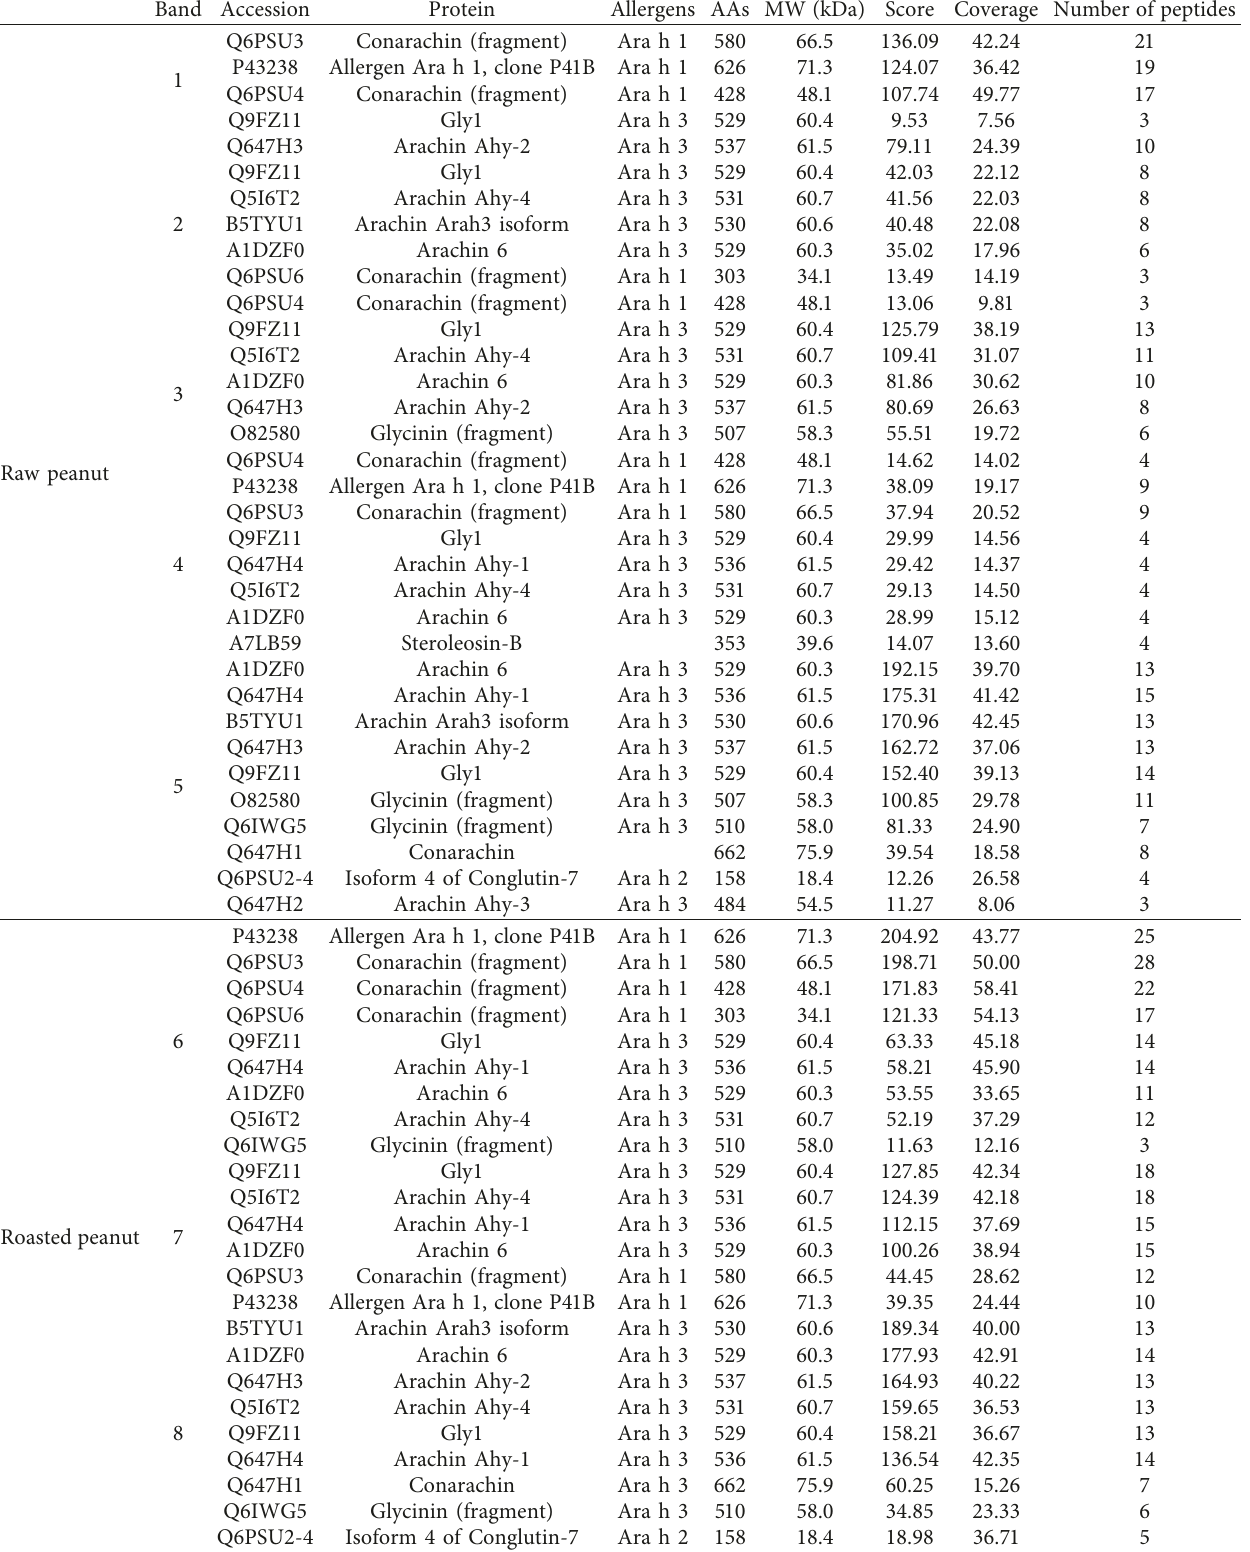
Table 1: Identification of protein bands from SDS-PAGE of raw and roasted peanut samples by LC-MS/MS analysis of tryptic peptides produced by in-gel protein digestion, coupled to commercial software-based protein